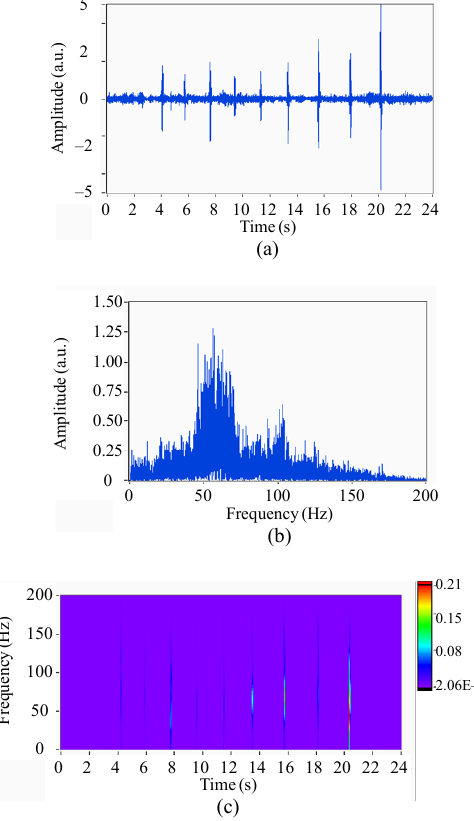
Fig. 24 (a) Time-domain waveform, (b) frequency spectrum, and (c) STFT when digging the ground at 1 m vertical distance away from the optical cable.